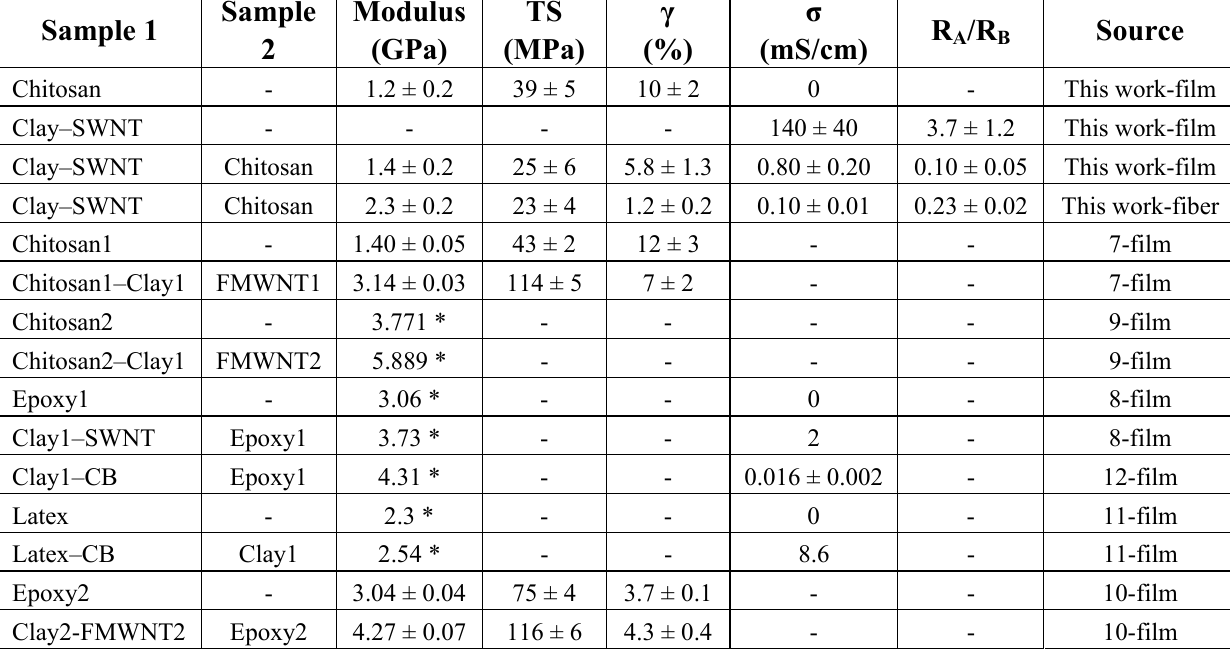
Table 2. Summary of Young’s/storage modulus (Modulus), tensile strength (TS), strain at break ( γ ), electrical conductivity ( σ ), ratio of resistance after (R to humid atmosphere for the different materials prepared by combining sample 1